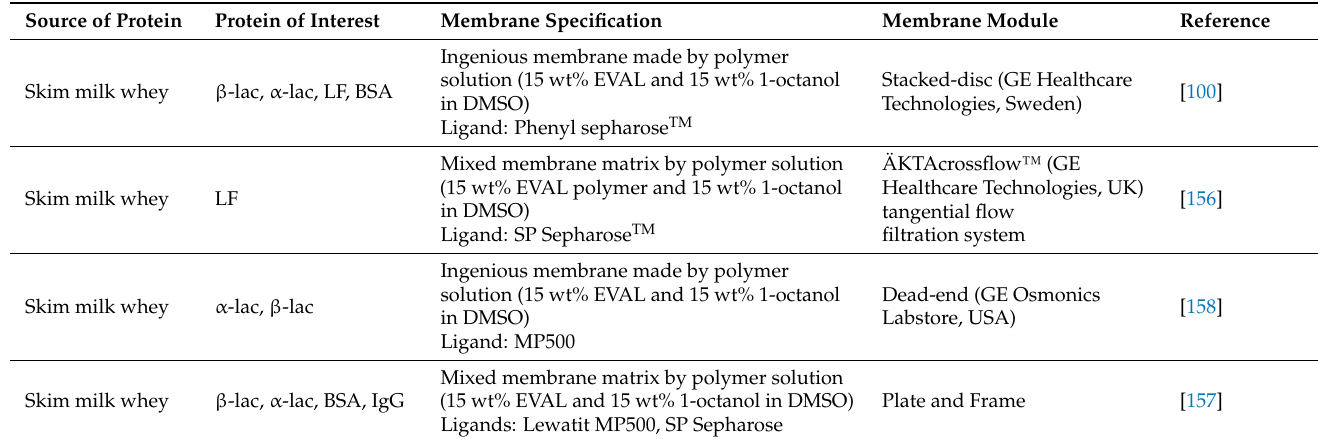
Table 5. Fractionation of proteins from whey by mixed matrix